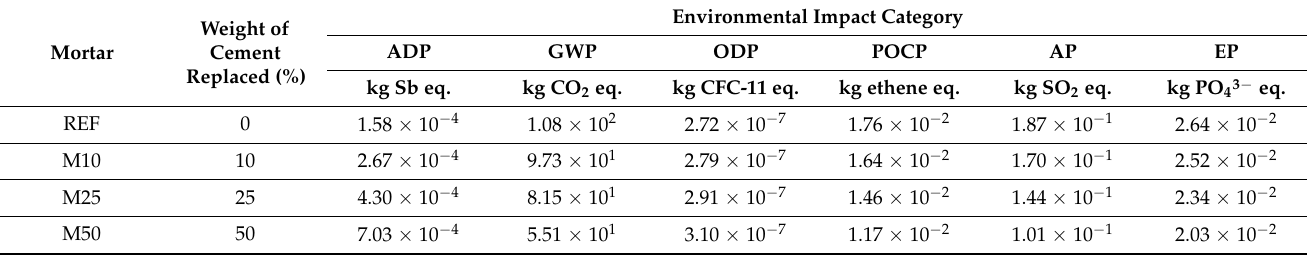
Table 4. Environmental impacts from the production of 1 t of mortars with cement and raw mining residues as binder